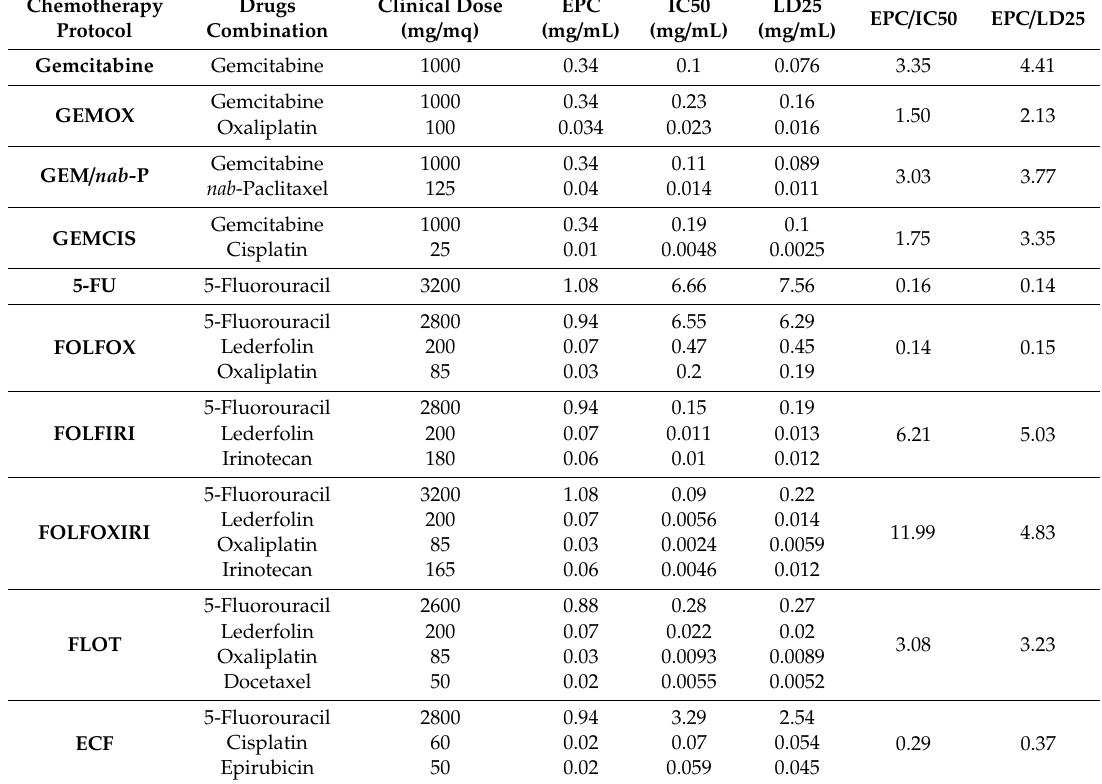
Table 1. Chemotherapy protocols tested in the study, and corresponding equivalent plasma concentration (EPC) calculated as EPC = clinical dose x BSA / V, as BSA is the reference value of the Body Surface Area (1.8 m 2 ) and V is the reference value of the blood volume (5.4 L). IC50, LD25 and relative ratio EPC / IC50, EPC /